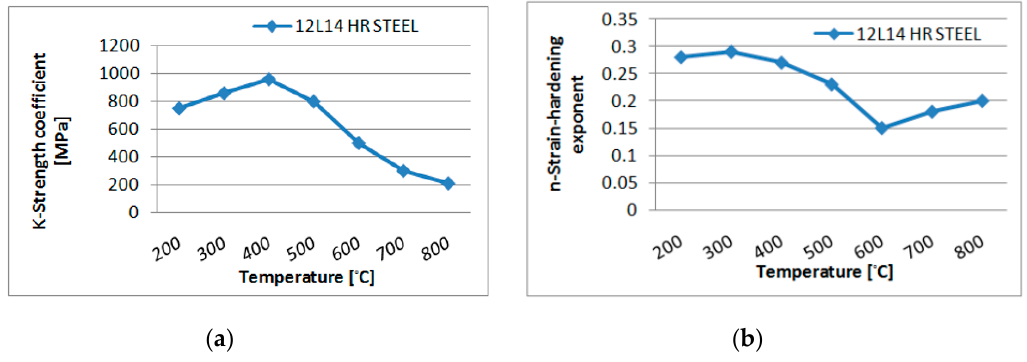
Figure 5. 12L14 HR steel characteristics ( a ) K at different temperatures; ( b ) n at different temperatures. The ten rolling passes carried out to reduce the overall thickness from 100 mm to 70 mm are characterized by the range of parameters in Table 2. Table 2. Rolling parameters at 10 passes for 3 different HR steel materials.